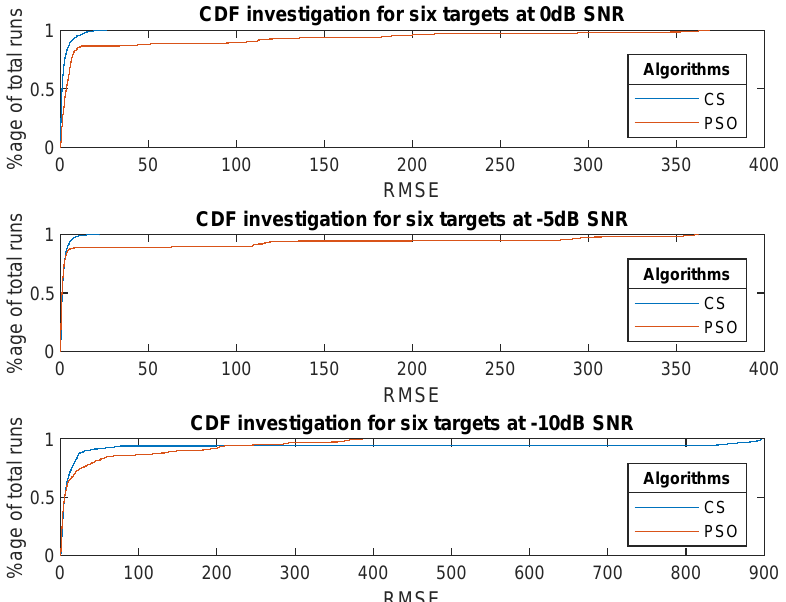
Figure 13. RMSE investigation in terms of CDF using six targets for various values of SNR.